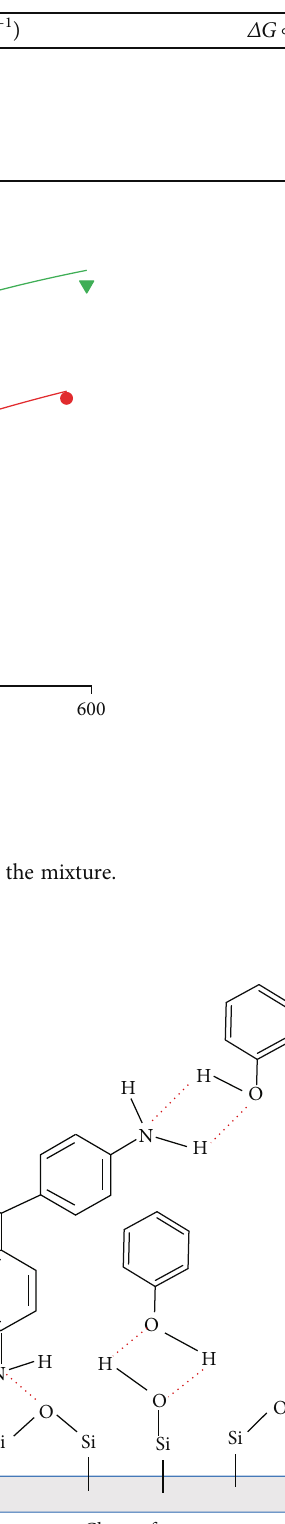
Table 4: Thermodynamic parameters for the adsorption of BF on GC.